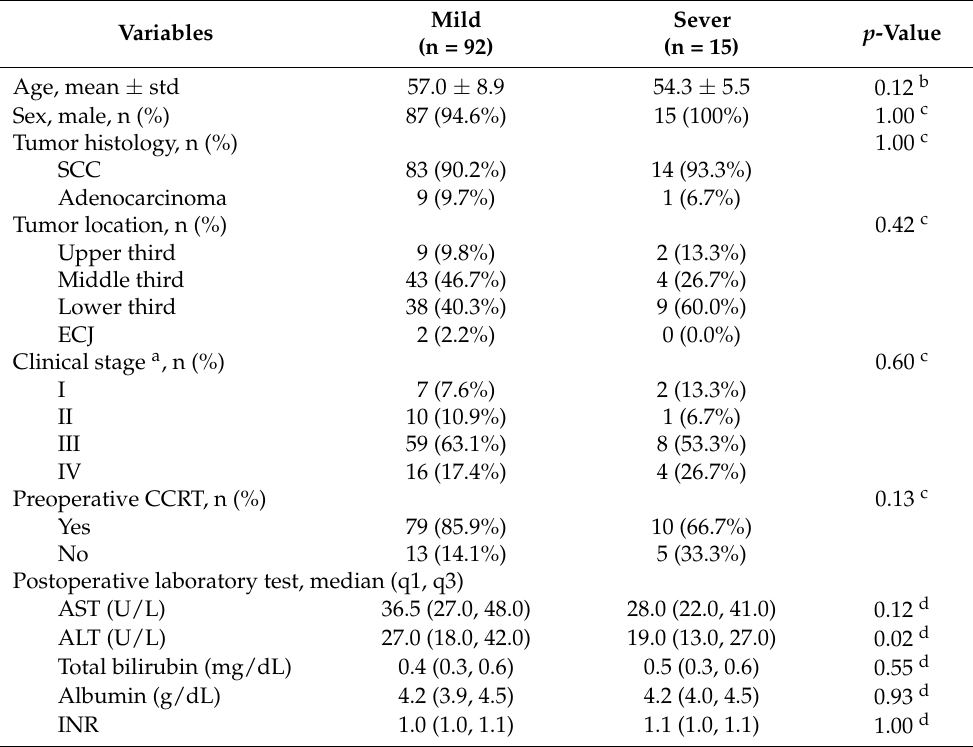
Table 1. Characteristics of the two groups.